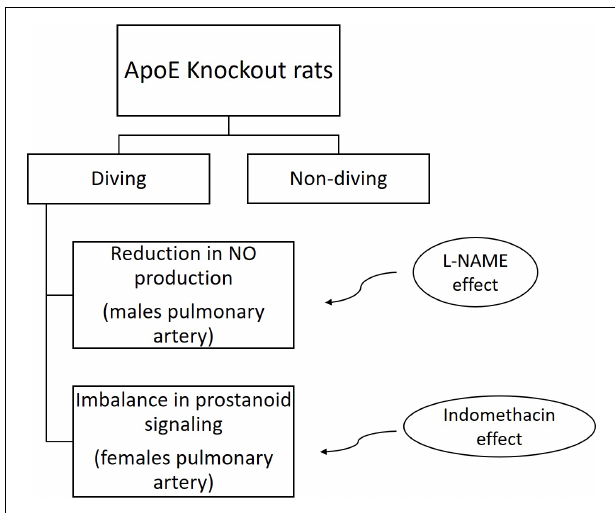
FIGURE 11 | Summery chart of main